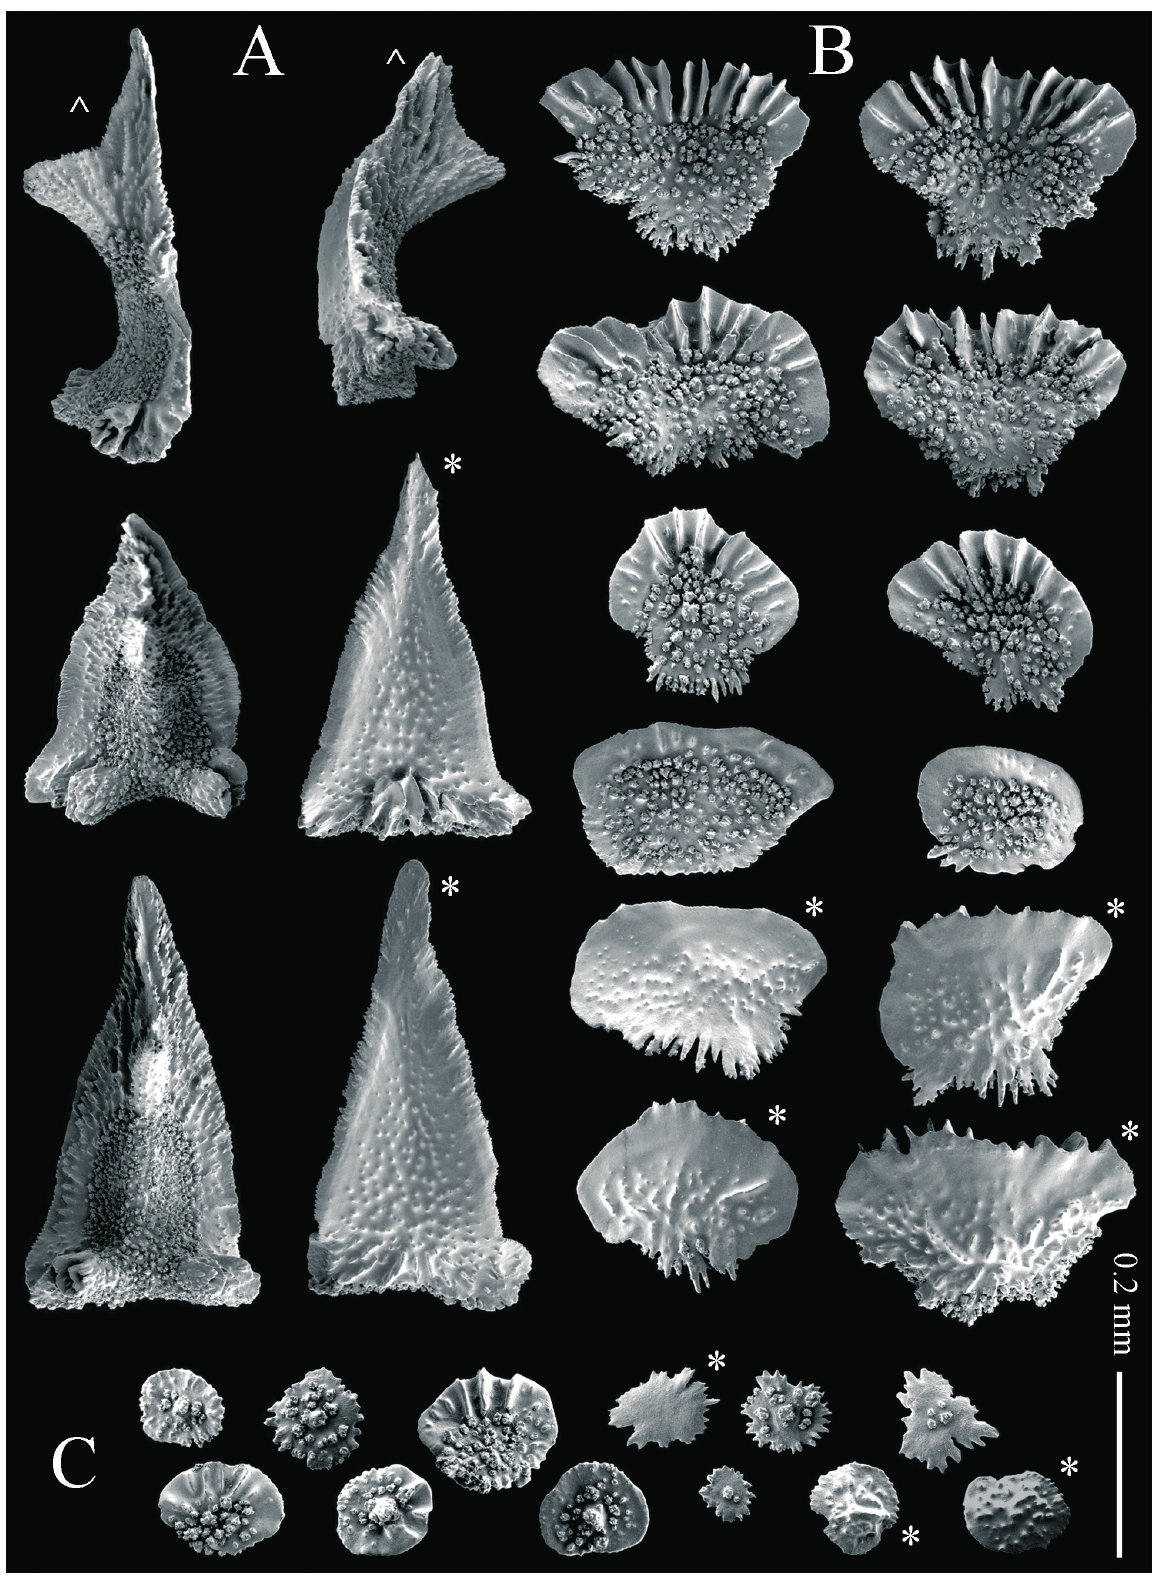
Fig . 25. – Primnocapsa plumacea (Thomson and Mackinnon, 1911) n. comb., holotype (AM G12123): A, opercular scales; B, marginal and body scales; C, coenenchymal sclerites. [* outer surface view; ^ lateral